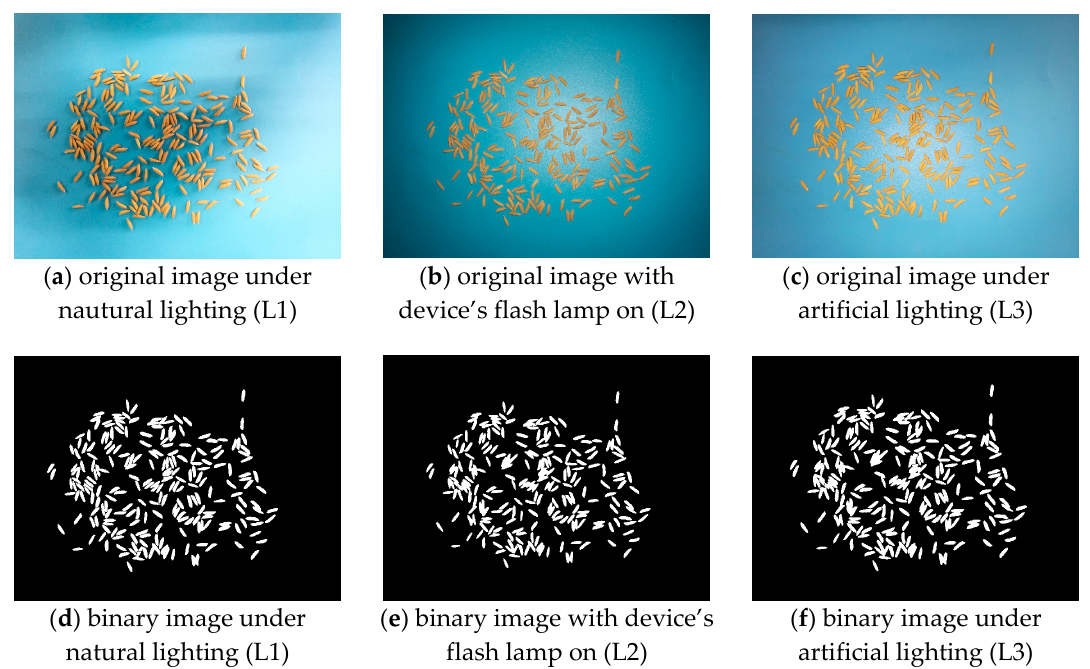
Figure 8. The counting results under different lighting conditions. Table 2. The performance evaluation of the accuracy of kernel counting using the “gainTKW” application on two different Android devices using six species of kernels (KN means kernel number).